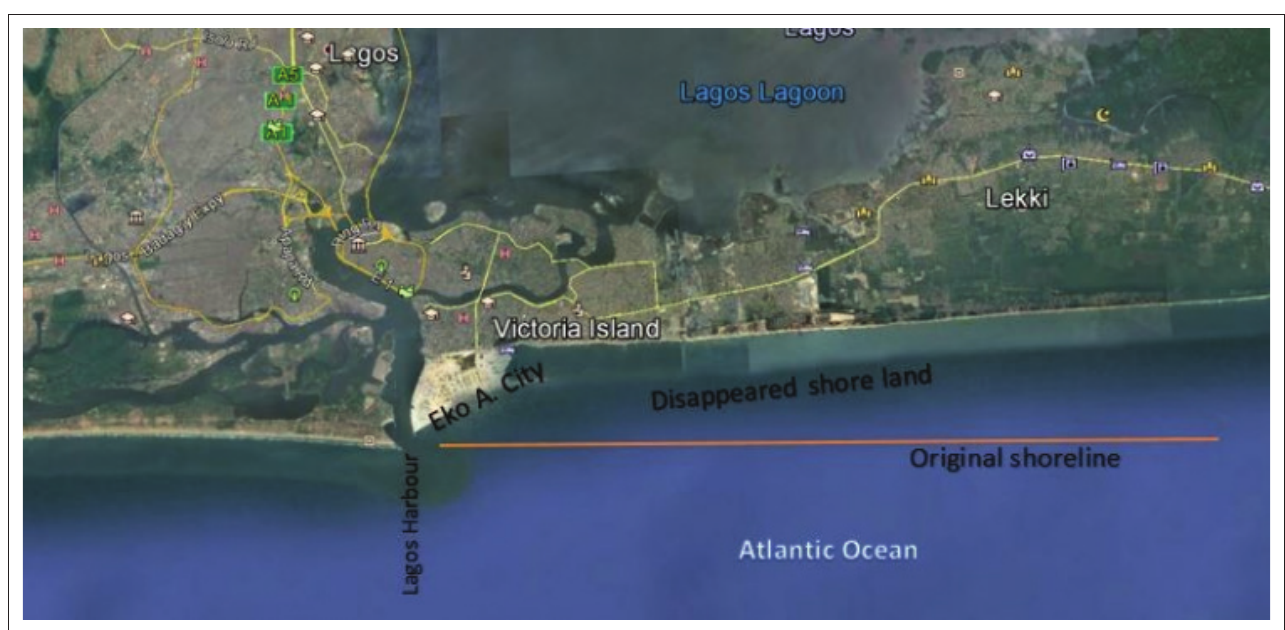
FIGURE 5: Relational location of Victoria Island, Lagos.